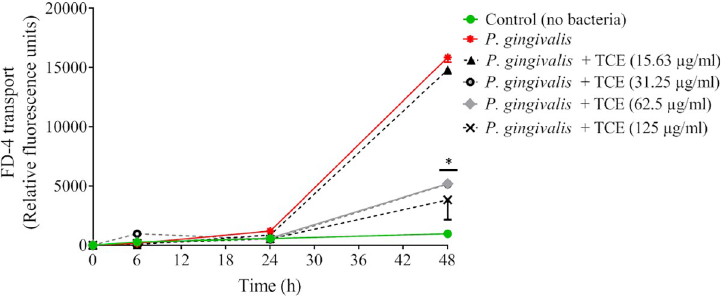
Fig 5. Effect of the tart cherry extract on the disruption of epithelial barrier integrity by P . gingivalis (MOI of 10 4 ) assessed by measuring FD-4 transepithelial transport over a period of 48 h. Results are expressed as the means ± SD of triplicate assays. � , Significantly different ( p < 0.01) from the control (no tart cherry extract).